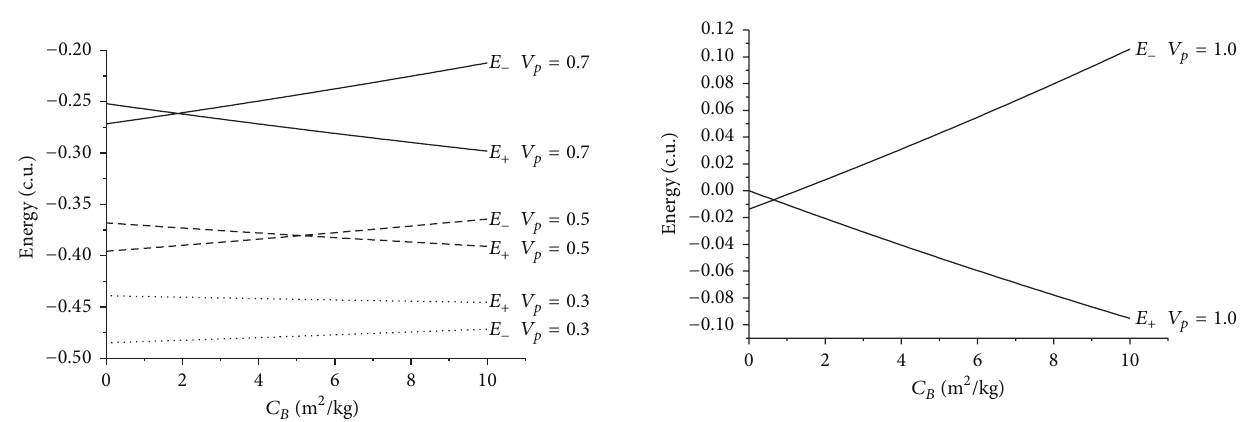
Figure 5: Evolution of the energies as a function of the ballistic coefficients for 𝜓 = 270 ∘ .